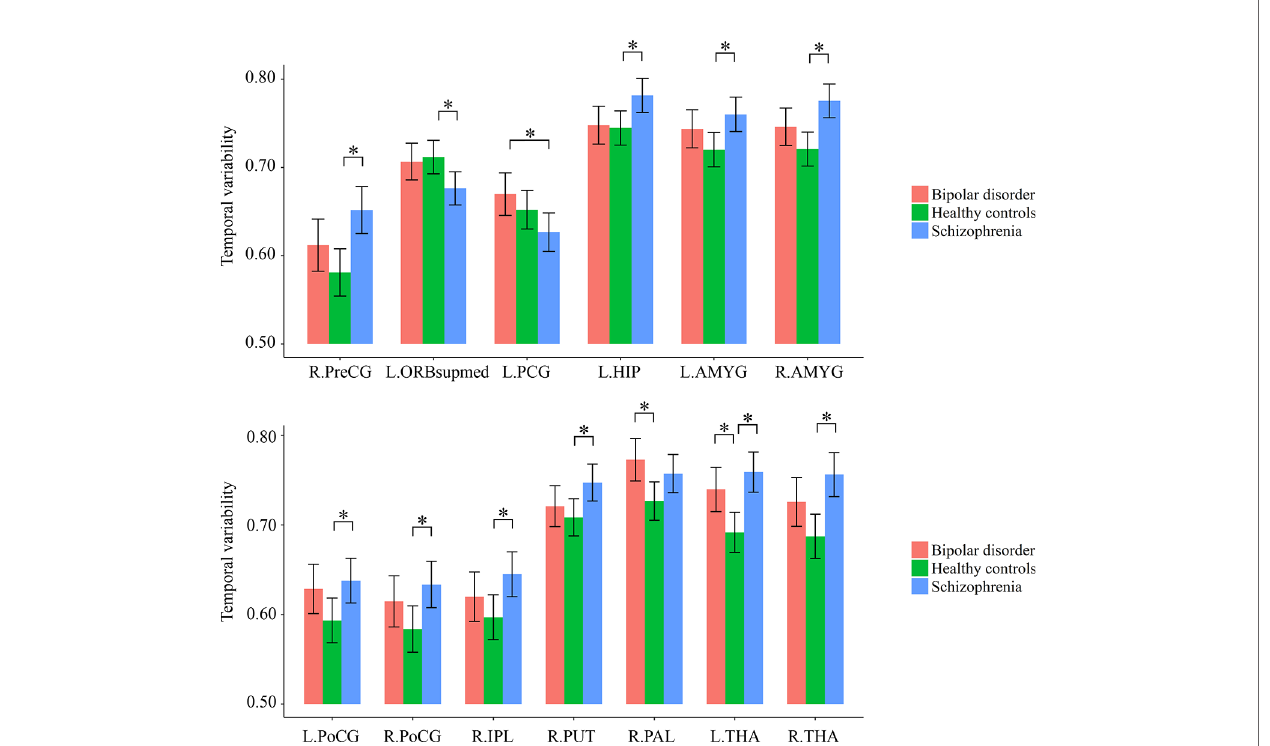
FIGURE 2 | Group differences in the temporal variabilities of regional FC patterns. The error bars present the 95% con fi dence intervals, and the marks “ * ” indicate signi fi cant between-group differences with corrected p < 0.05. AMYG, amygdala; FC, functional connectivity; HIP, hippocampus; IPL, inferior parietal lobule; L, left hemisphere; ORBsupmed, superior frontal gyrus (medial orbital); PAL, pallidum; PCG, posterior cingulate gyrus; PoCG, postcentral gyrus; PreCG, precentral gyrus; PUT, putamen; R, right hemisphere; THA,